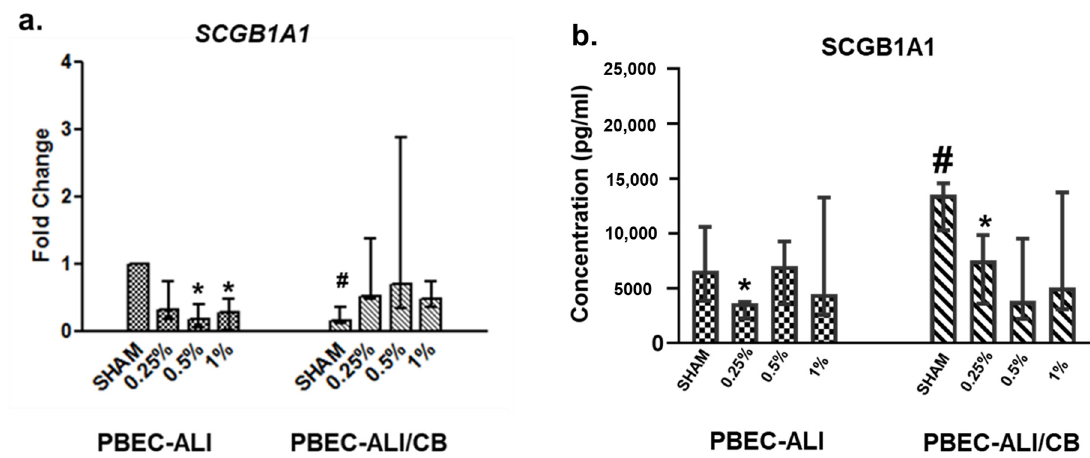
Figure 5. Transcript ( a ) and secreted protein levels ( b ) of secretoglobin family 1A member 1 (SCGB1A1) in the human normal-and chronic bronchitis-like (CB) bronchial mucosa models cultured at air–liquid interface (ALI) following exposure to 0.25%, 0.50% and 1% cigarette smoke condensate (CSC). Human primary bronchial epithelial cells (PBEC) from three donors (N) [three replicates/donors ( n )] have been used to develop the bronchial mucosa models. Actin beta ( ACTB ) was used as the reference gene. Fold changes for transcript expression were calculated relative to the corresponding sham. Data are presented as median (25th–75th percentile). N = 3; n = 3; non-parametric statistical analysis using Friedman test followed by Wilcoxon signed rank t test as a post hoc test, when appropriate, have been performed. p < 0.05: *: statistically significant compared to corresponding sham; # : statistically significant compared to sham exposed normal mucosa. PBEC-ALI: normal bronchial mucosa model; PBEC-ALI/CB: chronic bronchitis-like bronchial mucosa model.